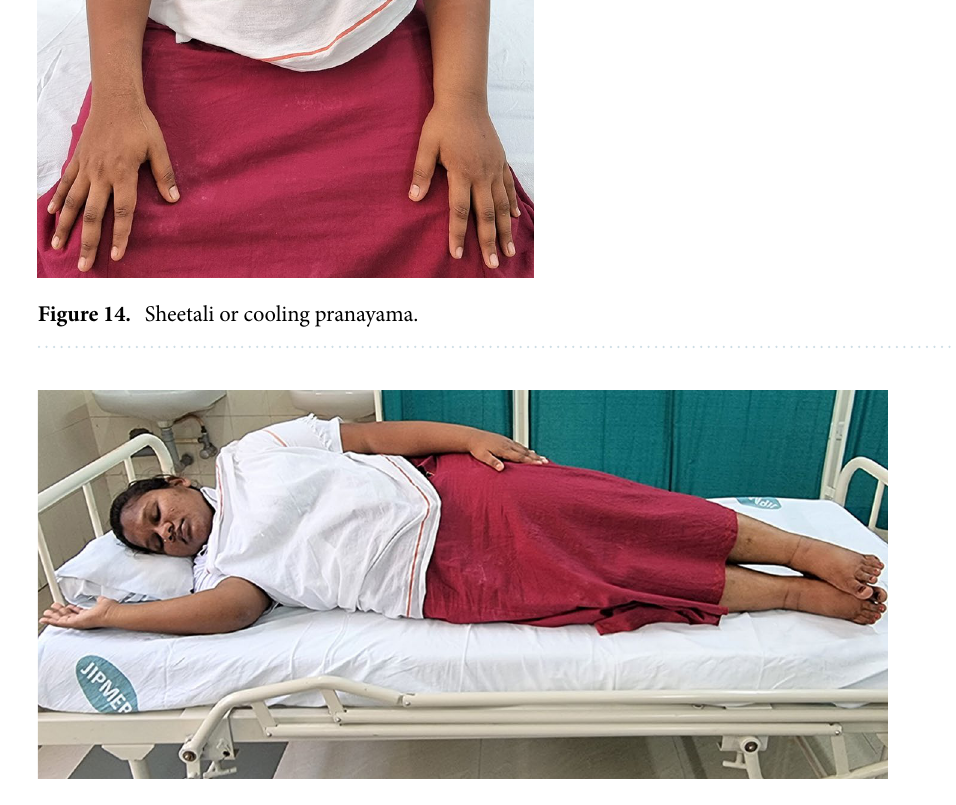
Figure 15. Relaxation in lateral